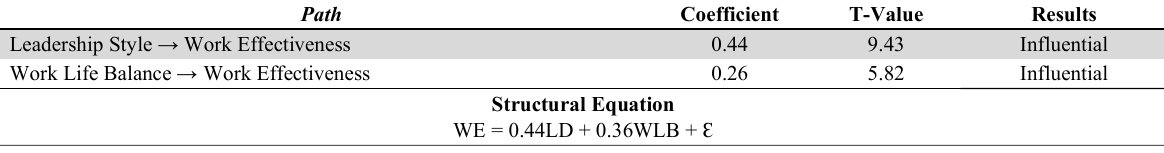
The influence of Leadership Style and Work-Life Balance on Work Effectiveness Path Coefficient T-Value Results Leadership Style → Work Effectiveness